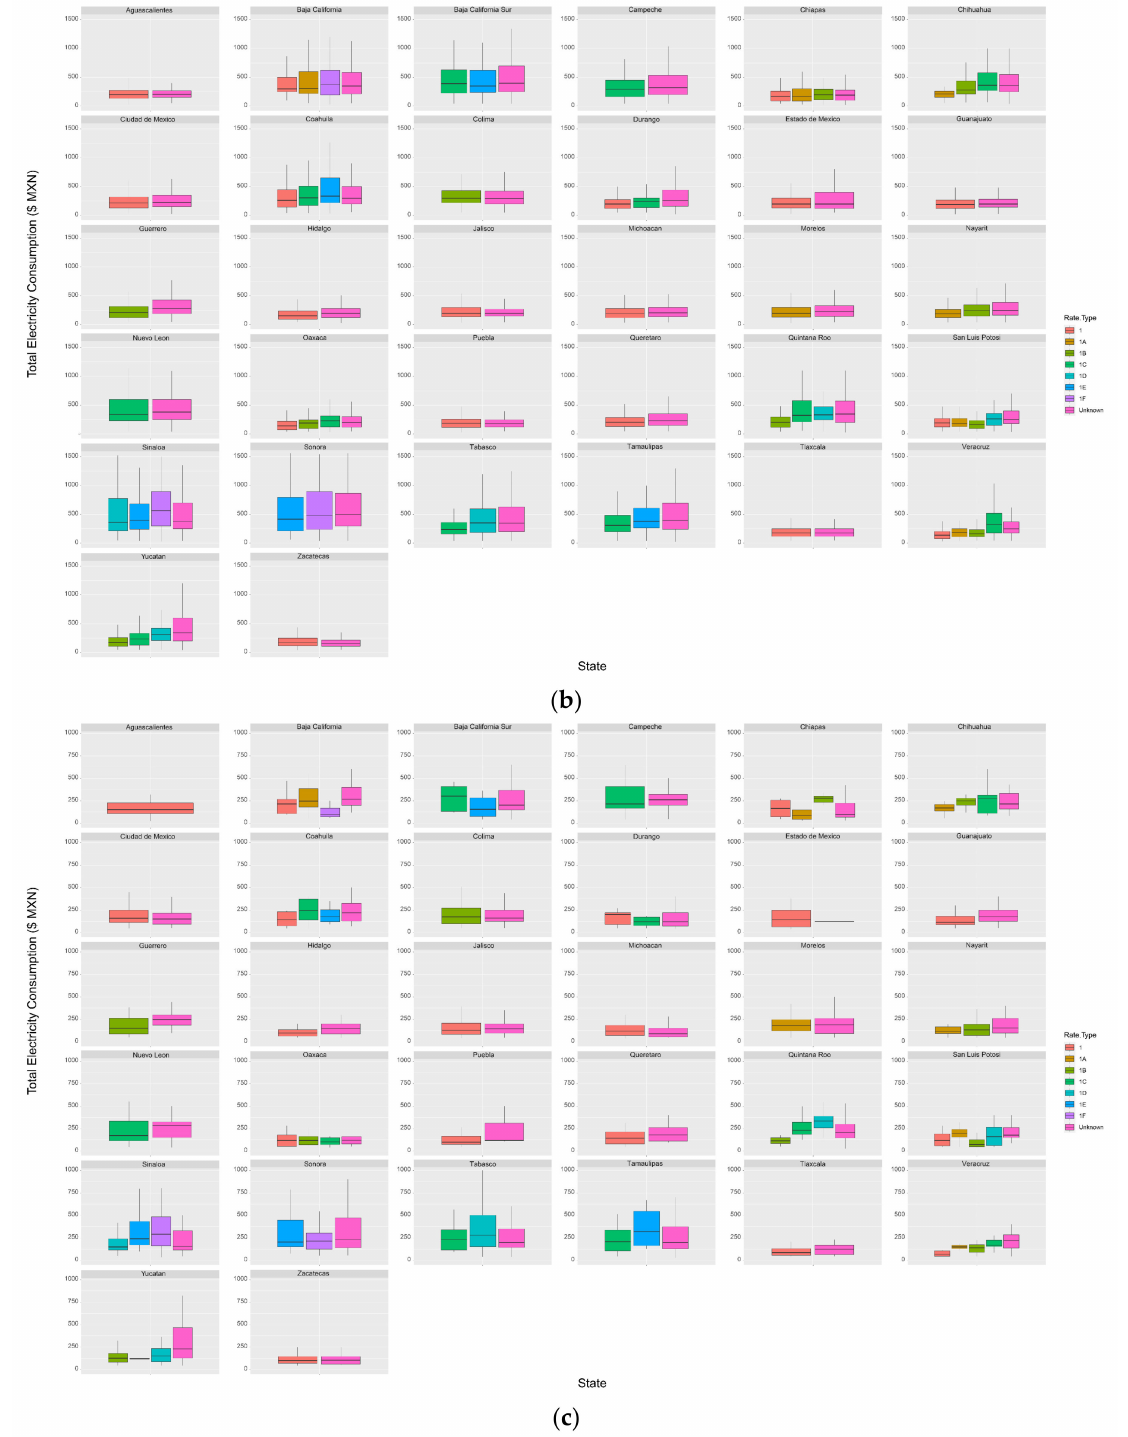
Figure 7. Boxplots by location: ( a ) personality traits, ( b ) electricity bill by rate type, and ( c ) electricity bill by rate type considering a single householder using air conditioning